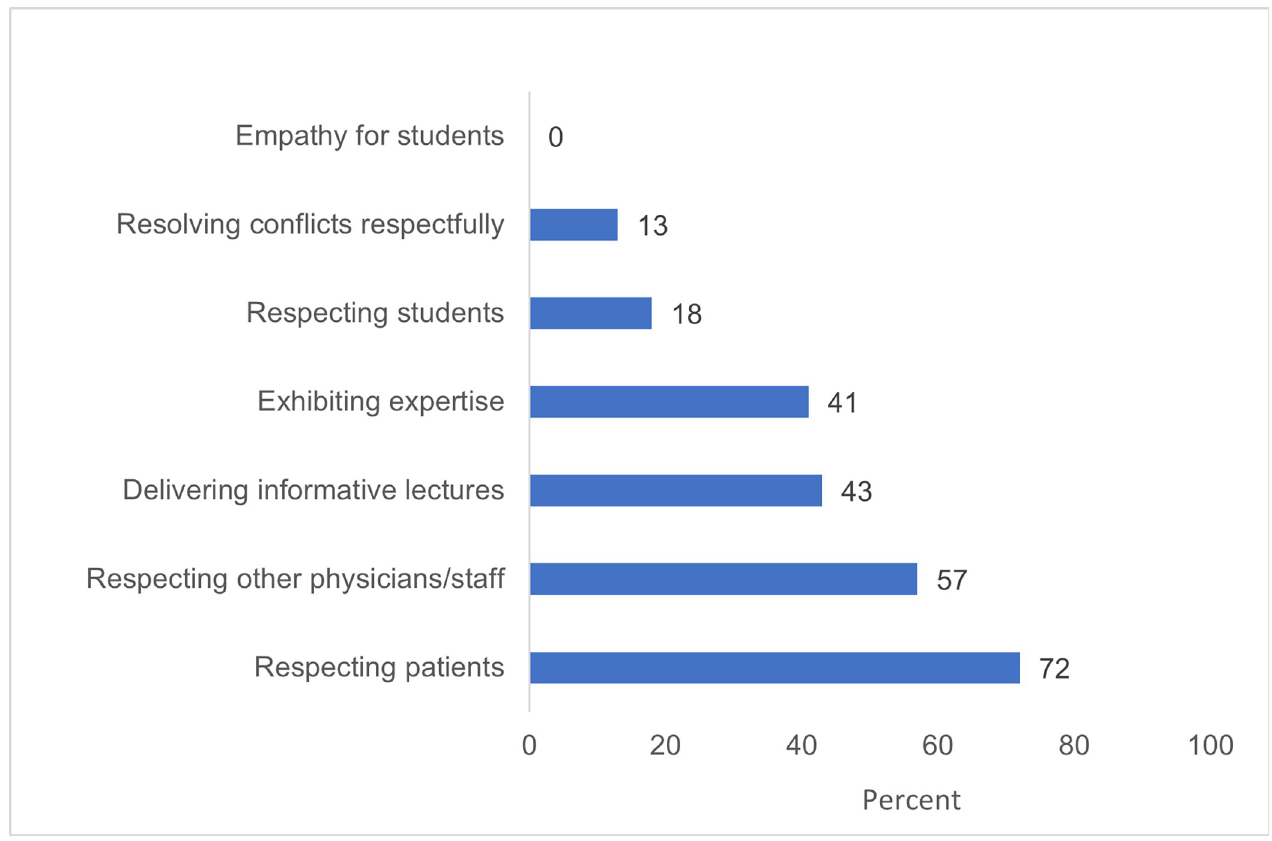
Fig 2. Percentage of AMD students who thought faculty display the following behaviors “most of the time” or “always” (2016).